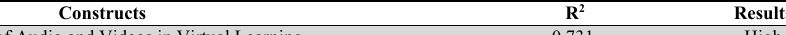
R 2 of the endogenous latent variables